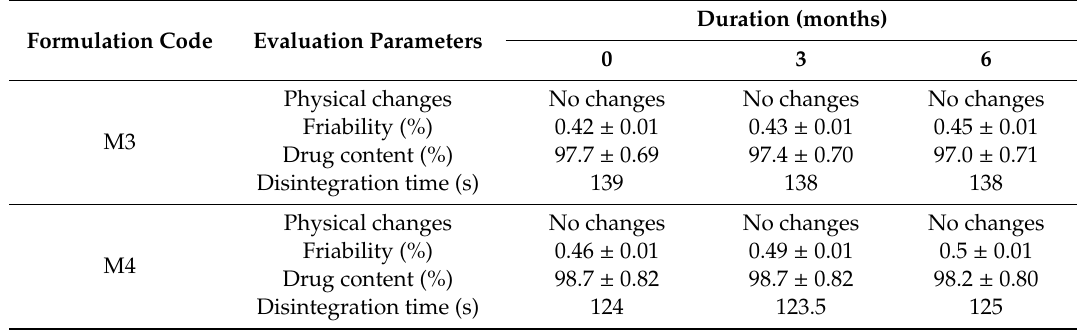
Table 2. Stability data of optimized formulations at 40 ◦ C and a relative humidity of 75%. Formulation